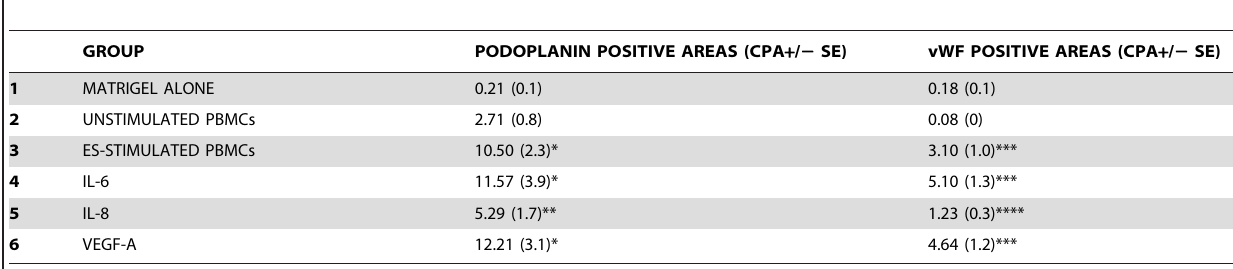
Table 2. Quantitative assessment of the presence of podoplanin positive areas (lymphatic endothelial elements) and vWF positive areas (blood endothelial elements) in treated Matrigel plugs recovered from rats 9 days after sub-cutaneous